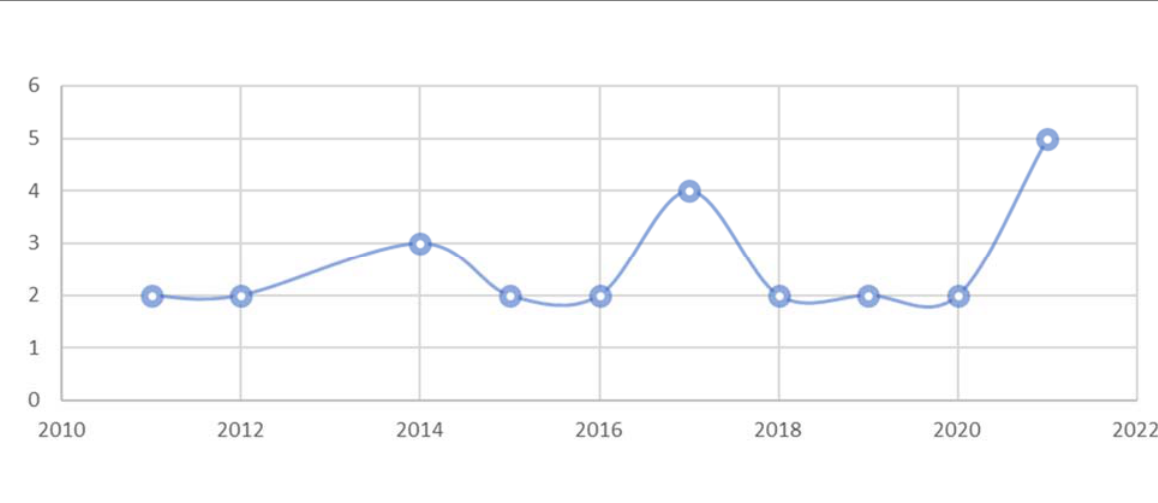
Figure 2. Number of Articles.